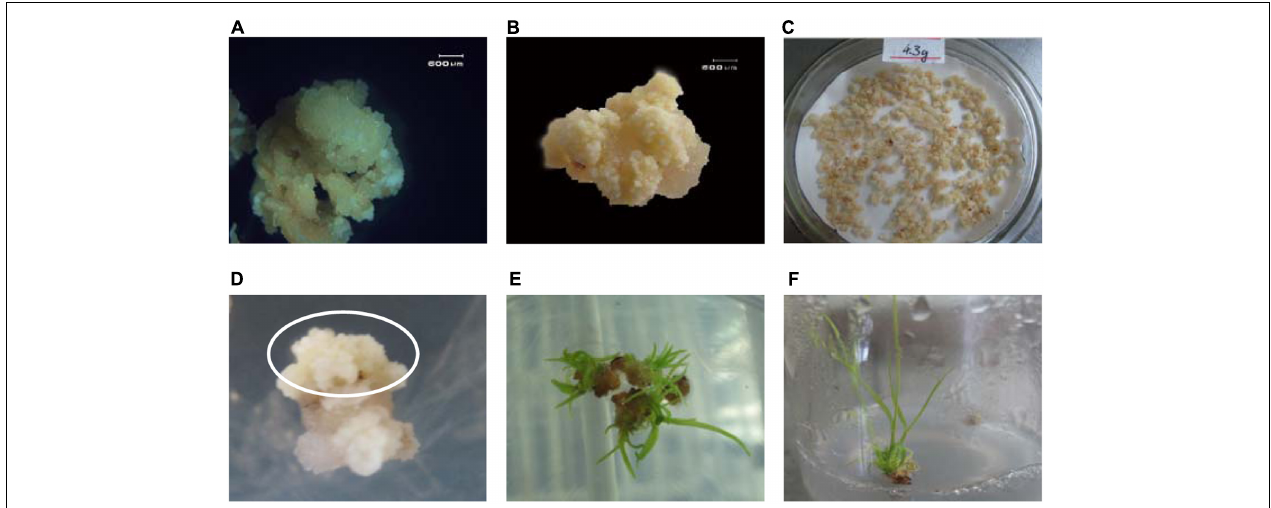
FIGURE 2 | Embryogenic callus induction and transformation. (A) Calli induced after 15 days; (B) : Embryogenic calli formed after 45 days; (C) : Embryogenic calli selected, fragmented, weighed, and air dried prior to transformation; (D) After 30 days of dark selection, several healthy resistant calli grew on the selection medium; (E) After 14 days of regeneration, healthy cultivation-resistant calli emerged rapidly; (F) After 20 days of elongation, cultivation-resistant, dark-green shoots grew quickly.